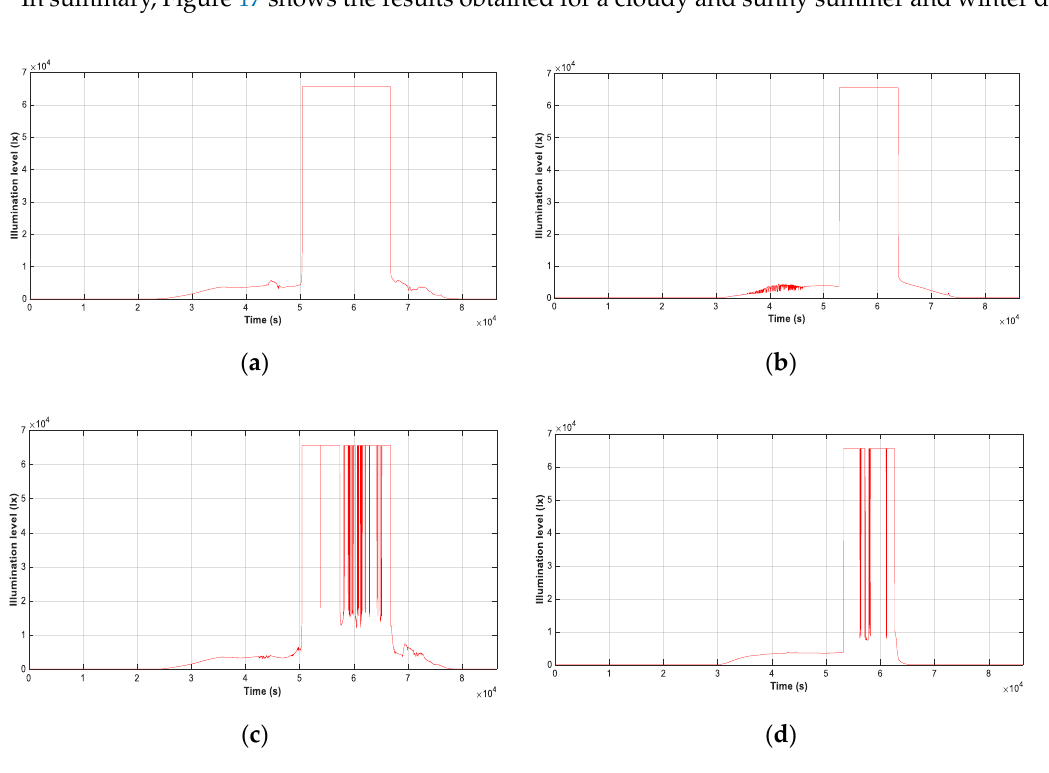
Figure 17. Study of lighting levels: ( a ) Summer sunny day; ( b ) Winter sunny day; ( c ) Summer cloudy day; ( d ) Winter cloudy day.